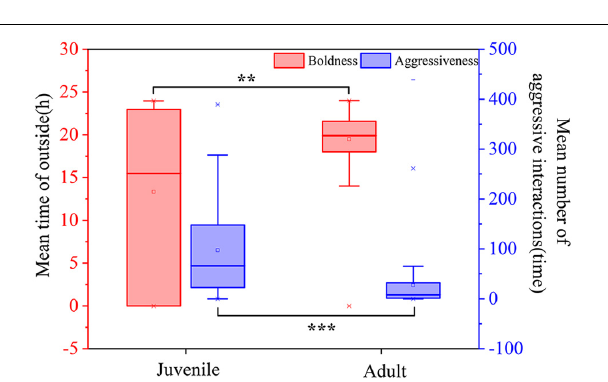
FIGURE 2 | Personality differences between juvenile and adult crabs. The left Y -axis represents the boldness of the crabs; the right Y -axis represents the aggressiveness. “**” indicated that there was a significant difference in boldness between juvenile and adult crabs, P < 0.01, and “***” indicated that there was an extremely significant difference in aggressiveness between juvenile and adult crabs, P < 0.001.